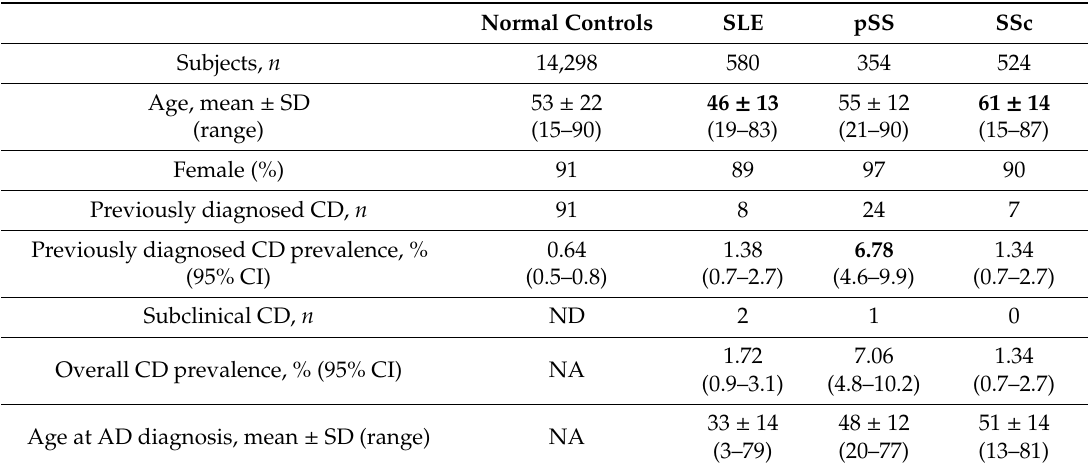
Table4. Epidemiologicalfeaturesof, andceliacdiseaseprevalenceinpatientswithsystemicautoimmune diseases and the control